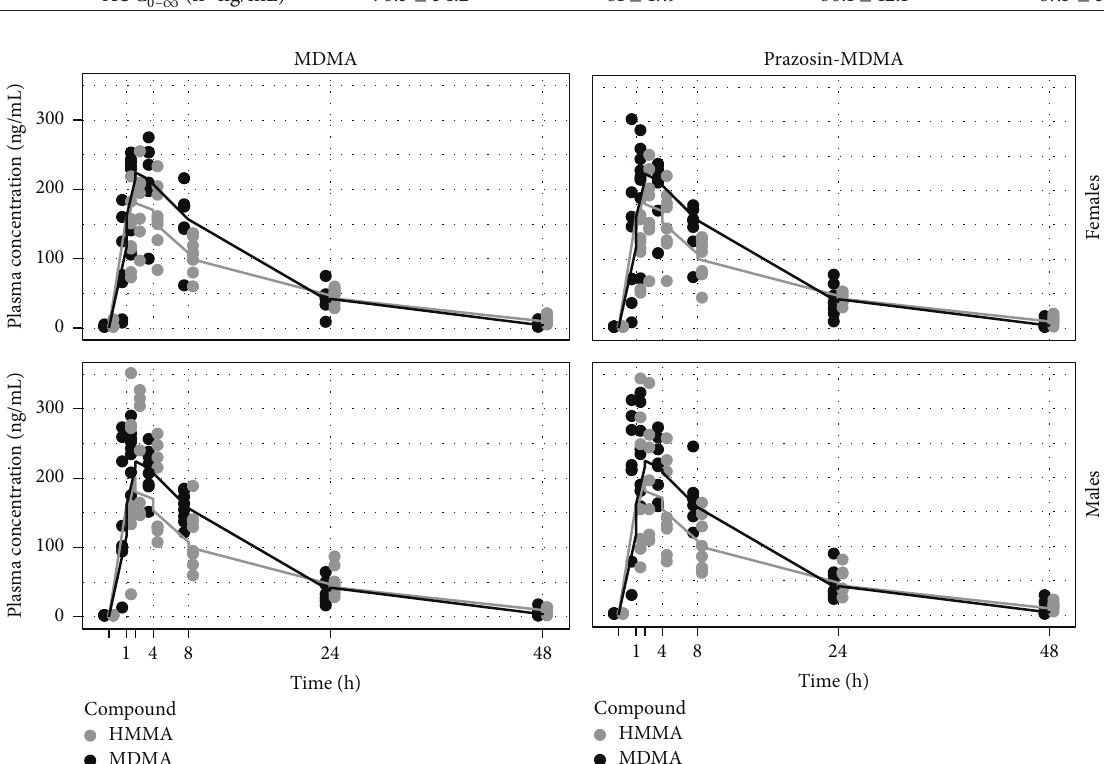
Figure 1: Plasma concentration versus time curves for MDMA (black) and HMMA (grey) from Study 1 after MDMA alone or prazosin with MDMA in male and female